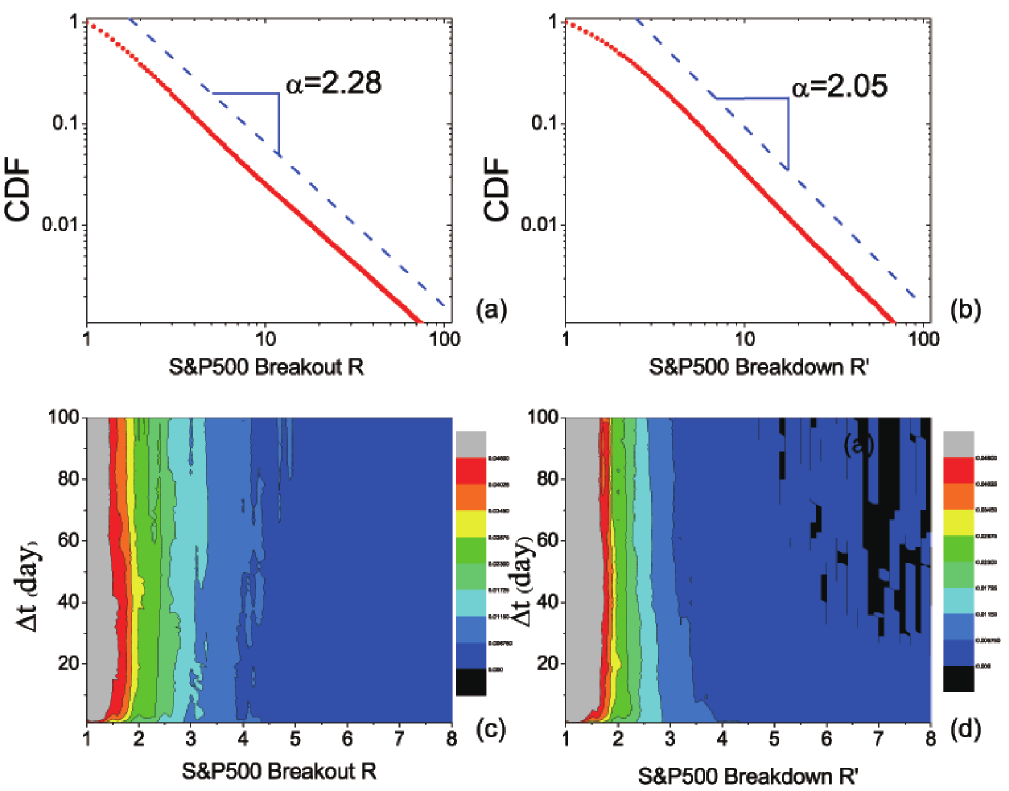
Figure 2. Distribution functions of R and R 9 for the S&P500 Index in the US stock market: CDF of (a) R and (b) R 9 ; PDF of (c) R and (d) R 9 for different time intervals, D T . The curve in either (a) or (b) appears to be a straight line in the log-log plot, which is indicative of a power-law fitting. The dash line is a guide to the eye. Regarding the fitting, more details are listed in Table 2.